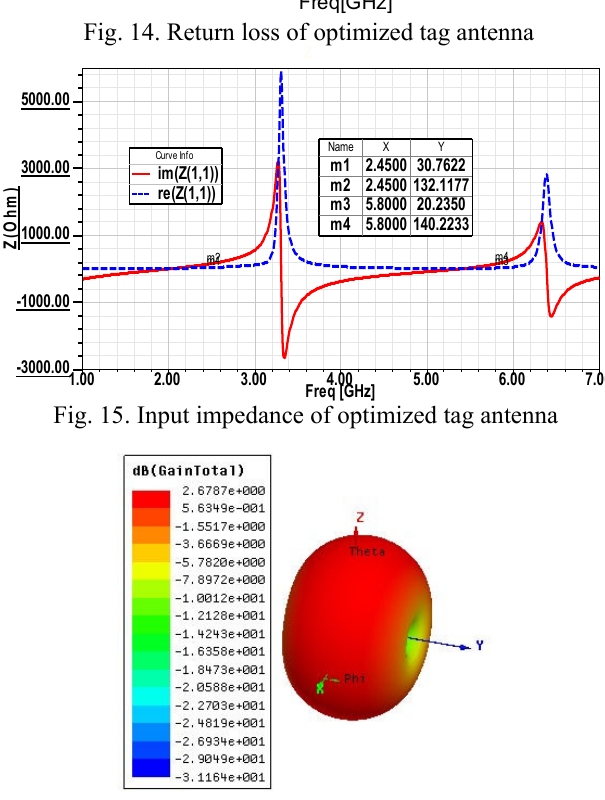
Fig. 16. 3D gain pattern at 2.45